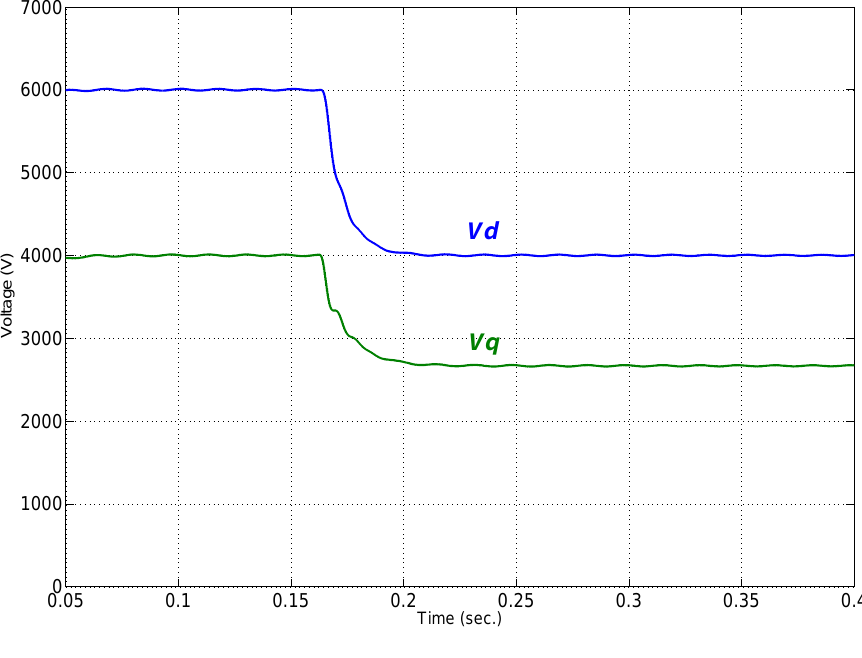
Figure 12. The d and q components of the load voltage generated by the Matlab/